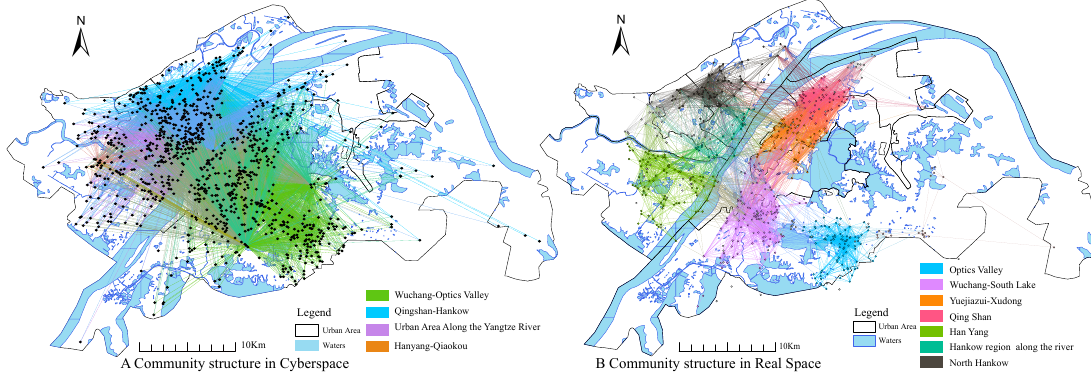
Figure 8. Community division structure of network-reality